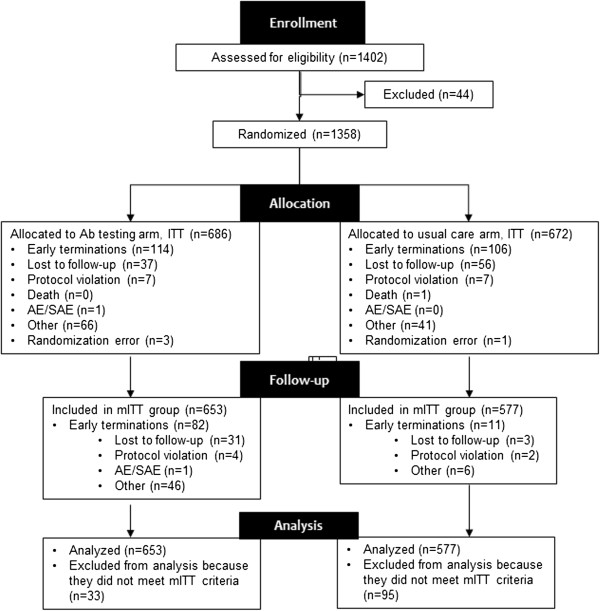
Patient disposition. Ab, antibody; AE, adverse event; ITT, intention-to-treat; mITT, modified ITT; SAE, serious adverse event.